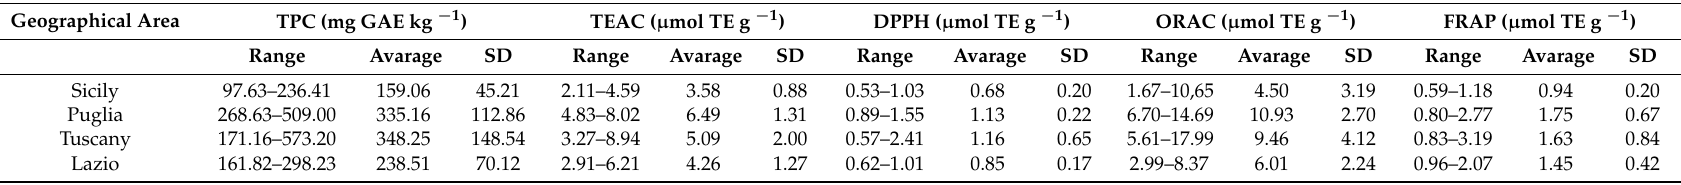
Table 2. Mean, minimum, and maximum TPC, TEAC, DPPH, and FRAP values of analyzed EVOO samples grouped by geographical areas.